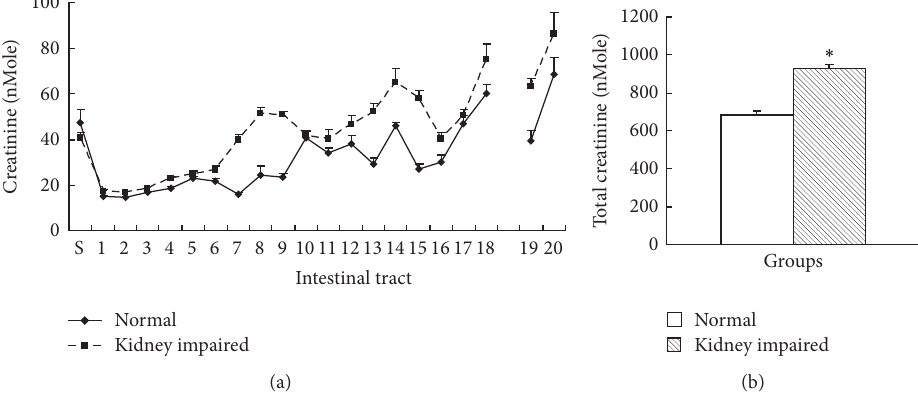
Figure 6: Creatinine in intestinal tract (mean ± SE, 𝑛 = 10 ). There were 20 segments of intestinal tract except cecum, and the content of creatinine was expressed as nMole (molar concentration multiplying volume) per segment. Creatinine in second and later segment of intestinal tract in kidney impaired group was higher than that in normal group (a), and the total creatinine in intestinal tract in kidney impaired group was also higher than that in normal group (b). Rats in kidney impaired group were intragastrically treated with adenine (400mg/kg × 5 days), while those in normal group were treated with normal saline of the same volume. S, stomach; 1 to 18 at horizontal ordinate meant the 1st to 18th segment of small intestine; 19 and 20 meant 2 segments of colon. ∗ versus normal group, 𝑃 < 0.05 , Student’s 𝑡